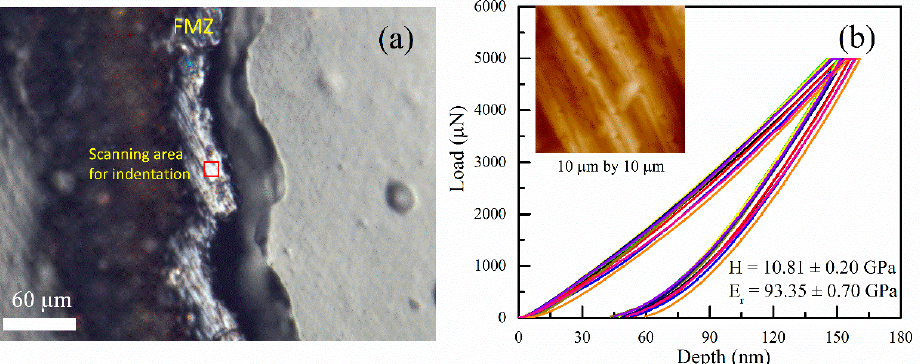
Figure 11. Cross-section morphology of single-layer Ti6Al4V sample via optical microscope ( a ). Red square in the FMZ shows the region where indentation tests were performed, and the hardness and elastic modulus values are calculated from the load–displacement curves ( b ), residue indents after indentation tests can be observed in the scanning image (inset of ( b )).